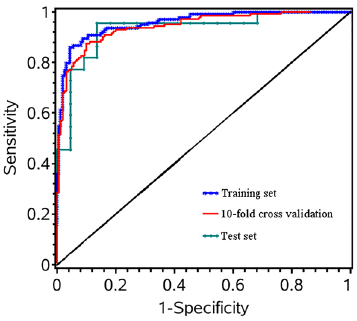
Figure 7. Receiver operating characteristic (ROC) curve was established to examine the performance of metabolite biomarker panel in distinguishing patients with GC from healthy individuals. ROC curve was marked with blue star for training set, red line for tenfold cross validation, and cyan dot for test